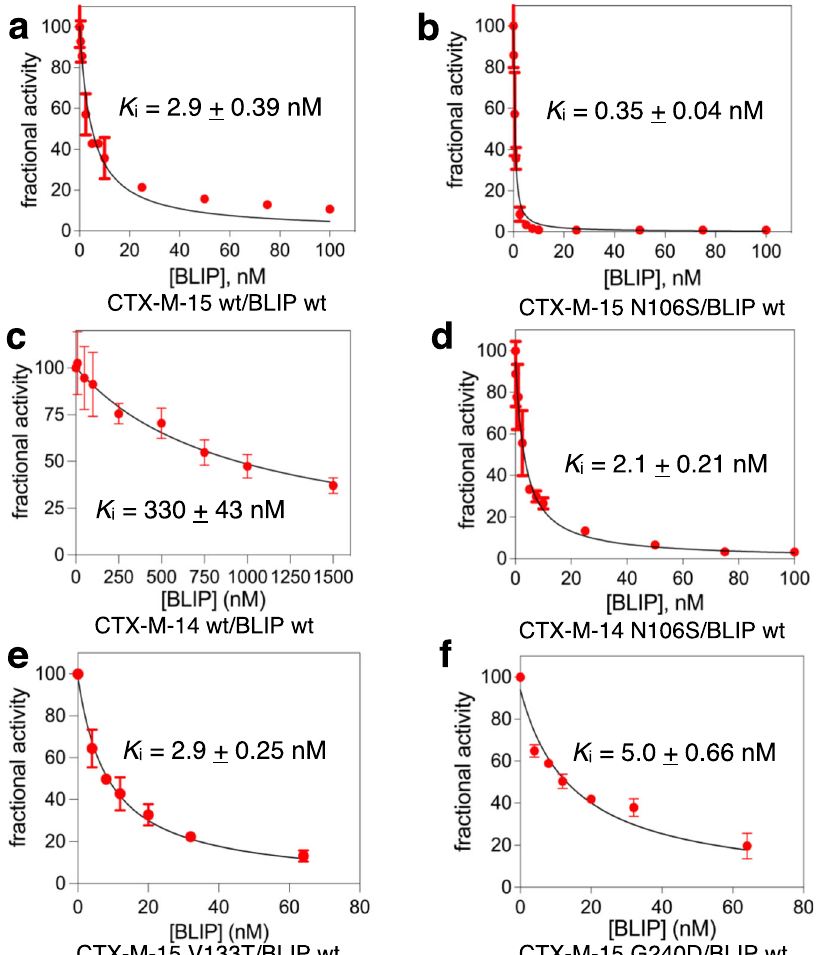
Fig. 2 | Determination of inhibition constants for β -lactamases. Inhibition constants ( K i ) for BLIP with a CTX-M-15 wild type, b CTX-M-15 N106S, c CTX-M-14 wild type, d CTX-M-14 N106S, e CTX-M-15 V133T, and f CTX-M-15 G240D β -lactamases. BLIP concentrations are indicated on the X-axis and the initial velo- city of nitroce fi n hydrolysis in the presence of BLIP divided by the velocity in the